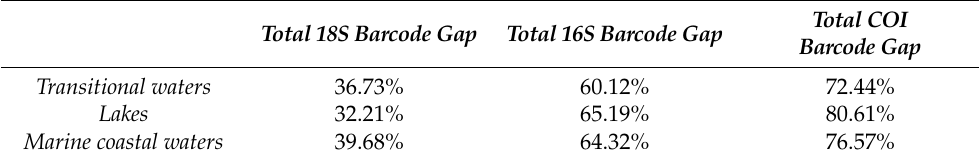
Table 1. Percentage of phytoplankton species without DNA barcode sequences in the reference libraries for each gene marker considered and aquatic ecosystem category.